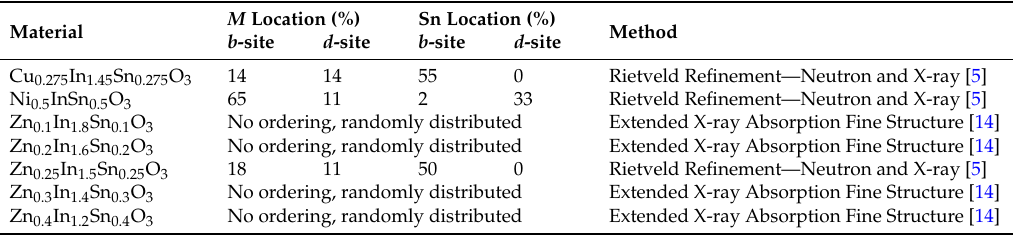
Table 2. Site occupancies of reported cosubstituted bixbyite phases. Indium occupies the remaining site